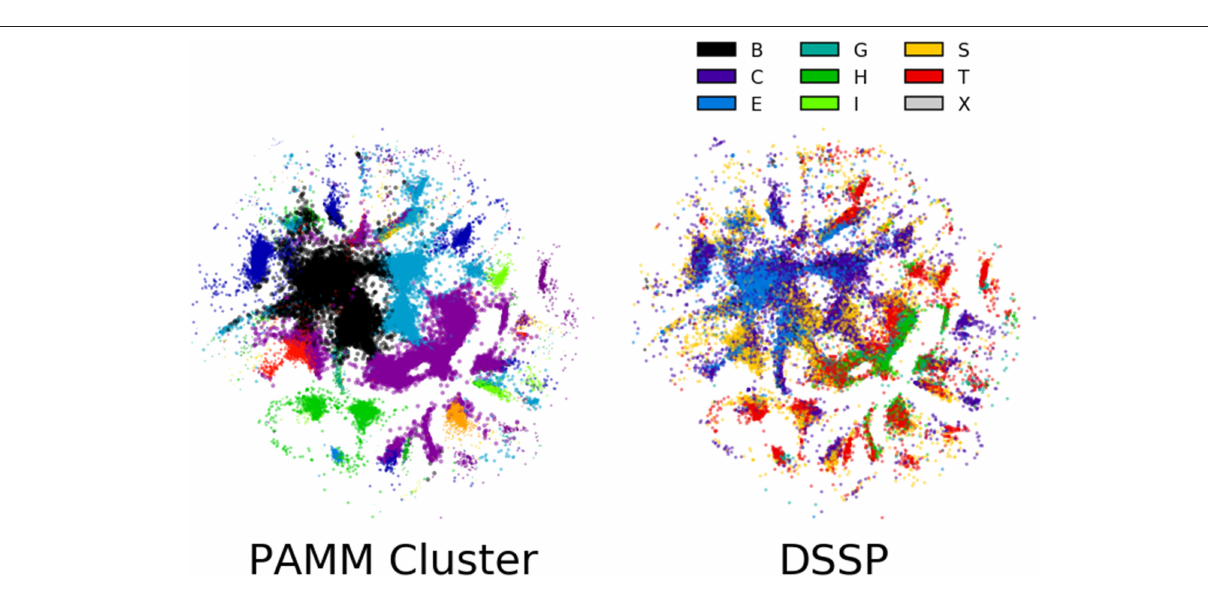
FIGURE 7 | Sketch-map representations of 100,000 randomly selected points in the six-dimensional φ , ψ space. Each point is colored according to its PAMM cluster assignment and middle residue DSSP secondary structure assignment. The lack of clear grouping observed among secondary structures suggests that secondary structure cannot be assigned based on dihedral angles alone. The points that are colored by their PAMM cluster are also sized based on the cluster weight; points belonging to a cluster with higher weight are